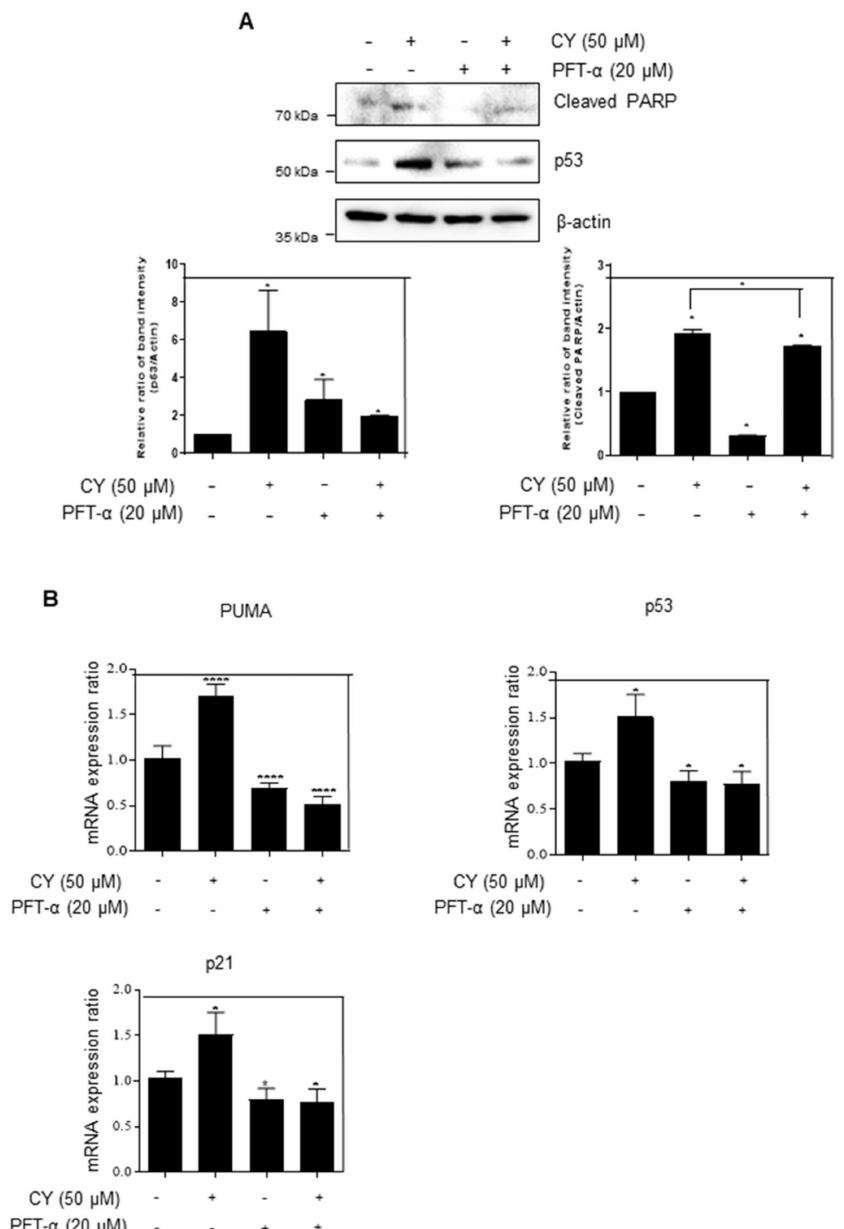
Figure 5. HCT116 p53+/+ cells were treated with the p53 inhibitor PFT- α . ( A ) HCT116 p53+/+ cells were treated with 20 µ M of PFT- α for 1 h before CY 50 µ M for Western blotting with p53, cleaved- PARP, and β -actin antibodies. ( B ) The relative mRNA expression level of p53, p21, PUMA were confirmed by qRT-PCR. mRNA expression levels were normalized to GAPDH. Ratio of each protein was determined by Image J. * p < 0.05. **** p <